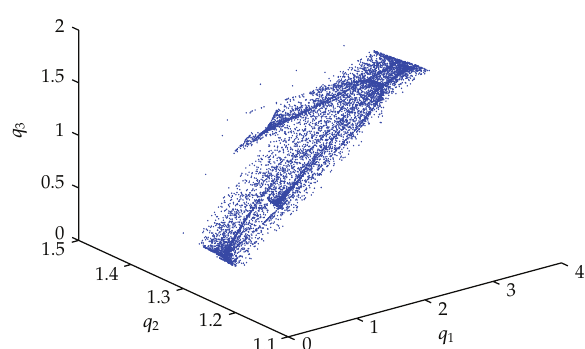
Figure 12: Strange attractor when β (cid:7) 0 . 2 ,α (cid:7) 23 .